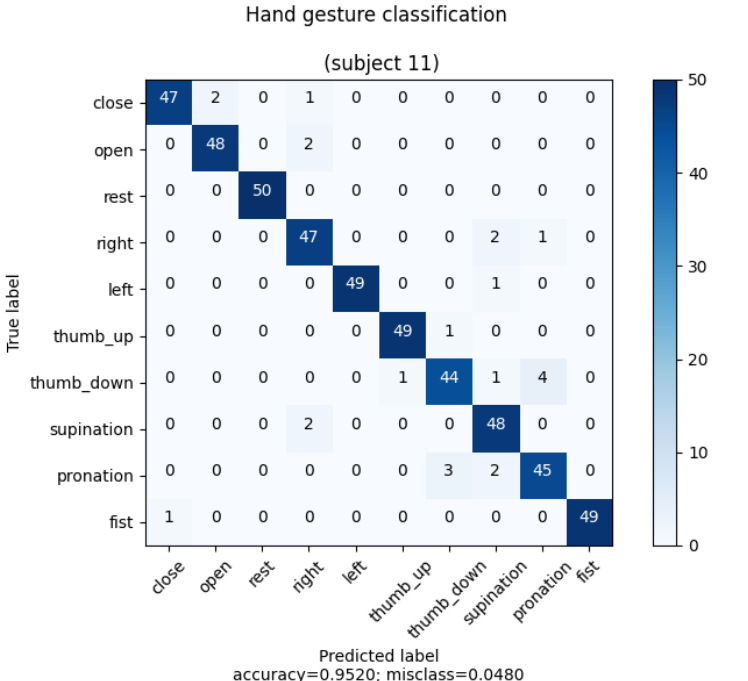
Figure A11. Confusion matrix of a subject who did not participate in data collection (subject